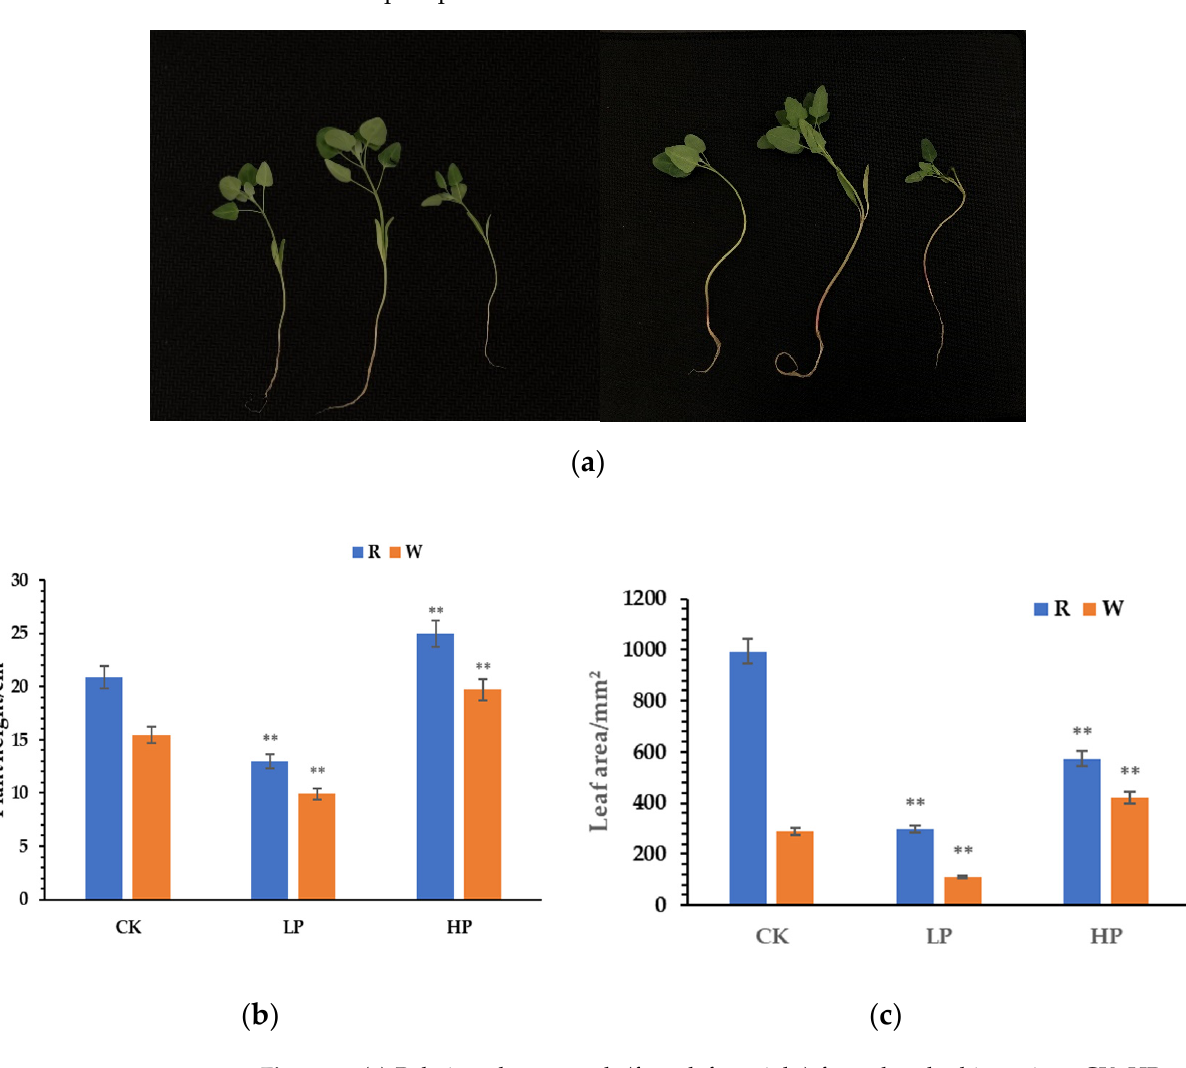
Figure 1. ( a ) Relative plant growth (from left to right) for red and white quinoa CK, HP, and LP. ( b ) CK, LP, and HP seedling heights. ( c ) CK, LP, and HP leaf areas. ‘R’ represents red quinoa, ‘W’ represents white quinoa; ** indicates that the seedling heights and leaf areas of each variety under various phosphorus concentrations were significantly different from those of the control condition at p < 0.01 (Student’s t-test).